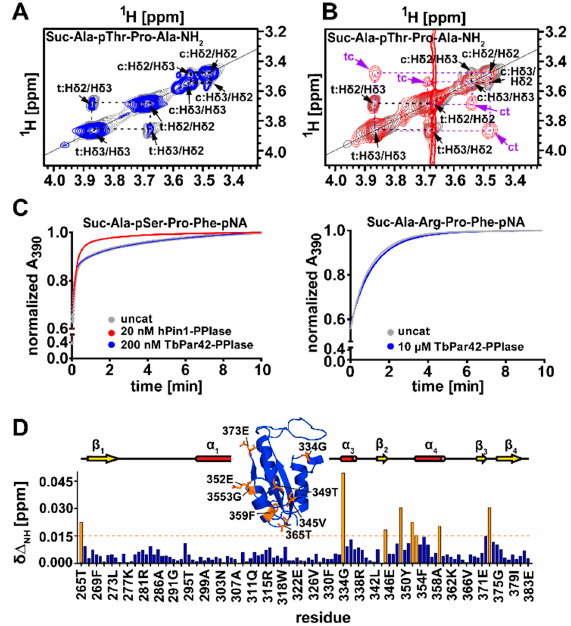
Figure 4. Catalytic activity and substrate binding of the PPIase domain. Exchange spectroscopy (EXSY) spectra of the proline-H δ protons of Suc-Ala-pThr-Pro-Ala-NH 2 peptide. ( A ) in the presence of Tb Par42-PPIase; ( B ) in the presence of h Pin1. The cis and trans conformers are indicated by c and t, and the resulting exchange peaks generated exclusively in B during isomerization are represented in purple by ct and tc. ( C ) Absorption curves monitoring the time dependent cleavage of pNA-containing model peptides (left: Suc-Ala-pSer-Pro-Phe-pNA ( h Pin1) and right: Suc-Ala-Arg-Pro-Phe-pNA ( Tb Par42-PPIase)) in a protease-coupled isomerase assay in the presence of Tb Par42-PPIase (blue) or hPin1 (red). The gray curve belongs to the uncatalyzed reaction without enzyme. A steep initial slope describes a fast isomerization. ( D ) Diagram of NH chemical shift changes ( ∆ δ NH ) observed in an 15 N-HSQC spectrum of Tb Par42-PPIase versus amino acid sequence after addition of 13 mM Suc-Ala-pThr-Pro-Ala-NH 2 peptide. Residues with a chemical shift larger than 0.015 ppm (orange dash line) are colored orange and mapped to the structure of the Tb Par42-PPIase domain. The secondary structure of Tb Par42-PPIase with helix represented in red, β -strand in yellow, and coil as line is shown on top of the